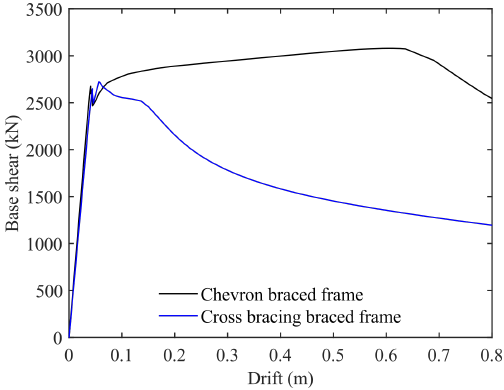
Figure 7. Pushover curves for the braced